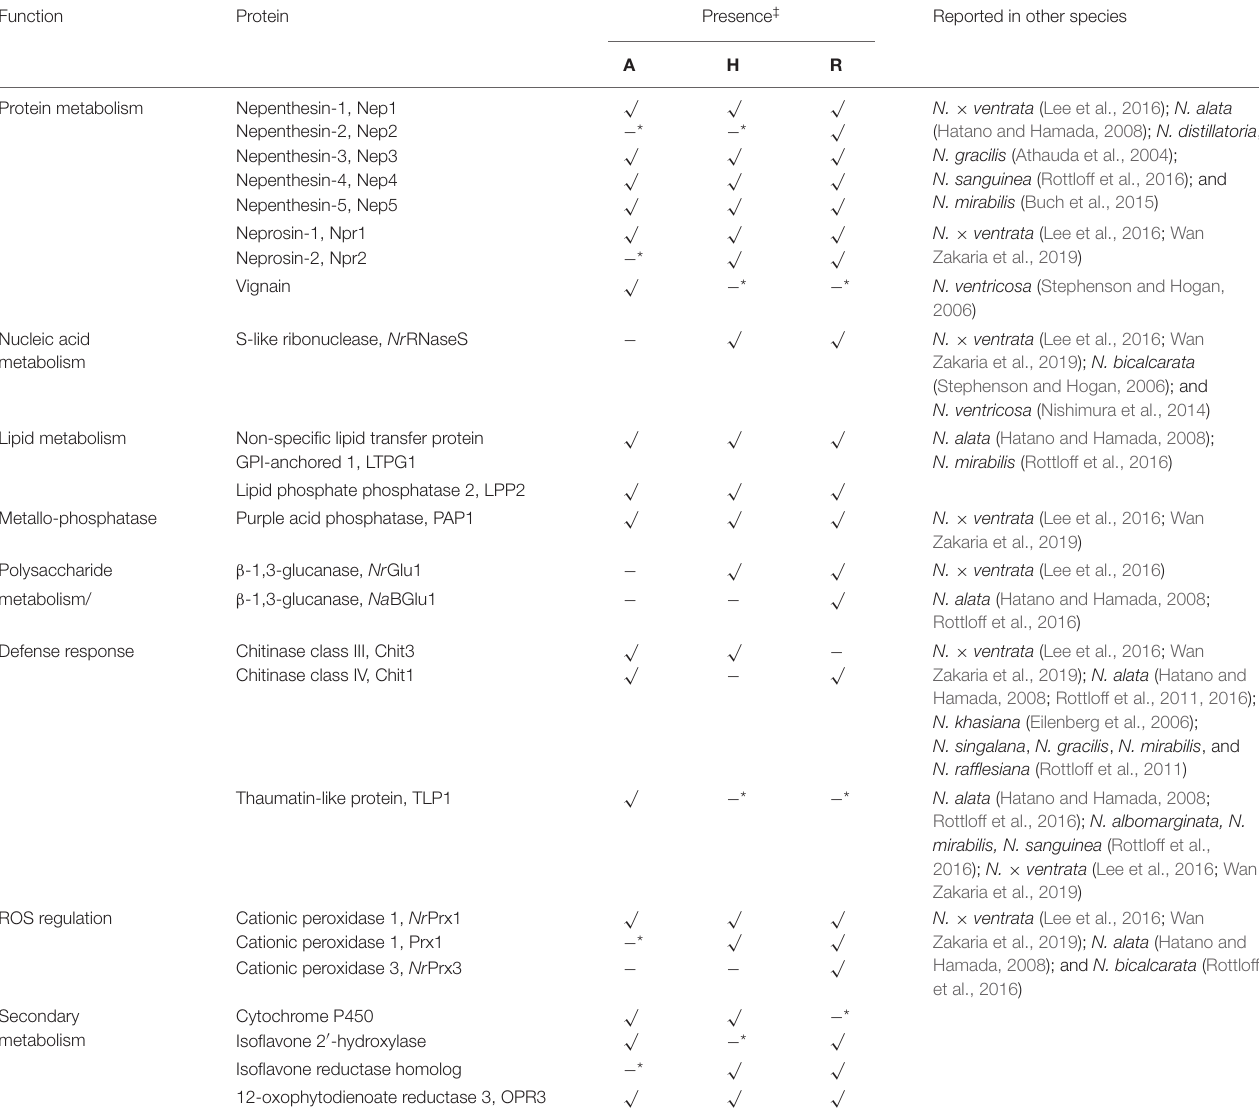
TABLE 3 | List of identified endogenous proteins important in Nepenthes carnivory traits from non-fed pitchers.